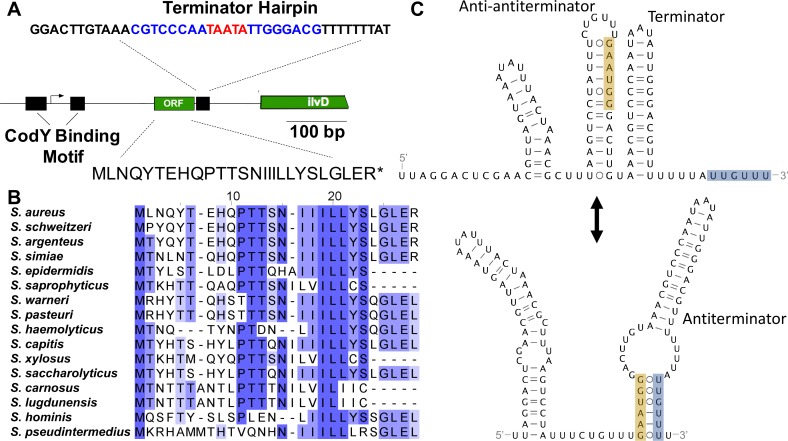
Attenuator features upstream of ilvD.A) The position and sequence of the terminator hairpin is shown for the WT USA300 strain and the ValSup-5 mutant strain. The terminator sequence is in bold, with the stem highlighted in blue and the loop highlighted in red, followed by a poly-U tail. The putative open reading frame (ORF) and the corresponding translated attenuator peptide is shown for the WT USA300 strain and the ValSup-1 mutant. The positions of the features are indicated relative to the transcriptional start site identified in Majerczyk et al., 2010. B) Multiple sequence alignments of the homologous peptide found in the ilvD leader from other staphylococcal species. C) Alternate RNA secondary structures of a terminator and antiterminator predicted in the ilvD leader using the Mfold webserver. The alternatively paired segments in the antiterminator stem are highlighted in orange and gray. Base pairing is shown using Leontis-Westhof notation. ValSup is abbreviated to ValS.